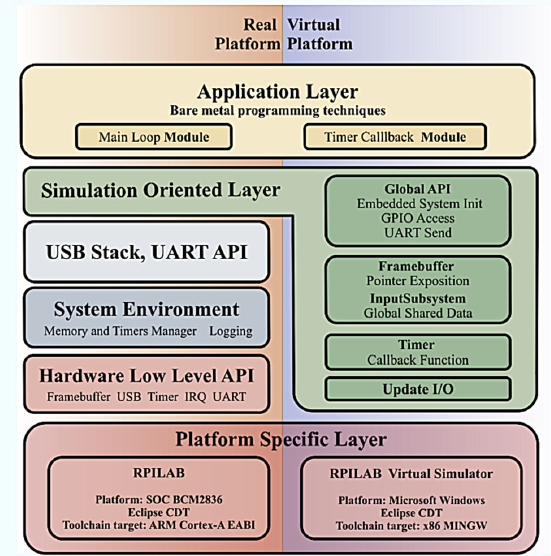
Figure 9. Software ‐ architecture layers for application developing using Bare ‐ Metal techniques on Figure 9. Software-architecture layers for application developing using Bare-Metal techniques on RPILAB module and its virtual simulator. RPILAB module and its virtual